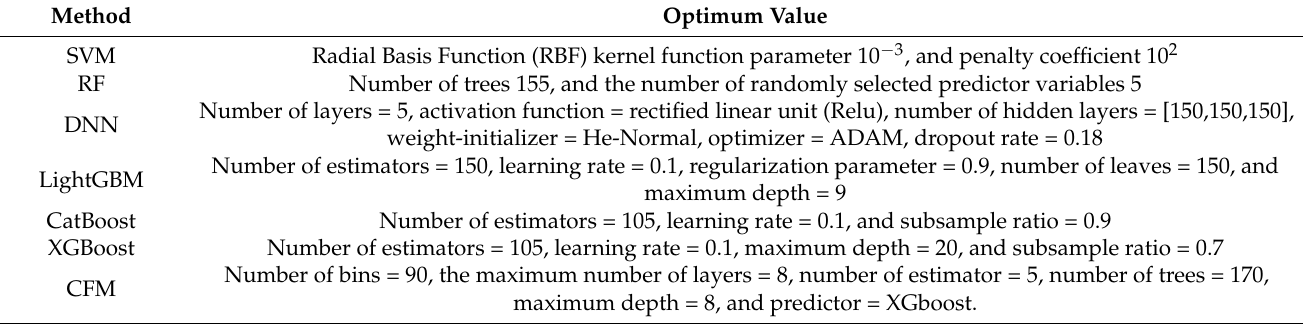
maximum depth = 8, and predictor =